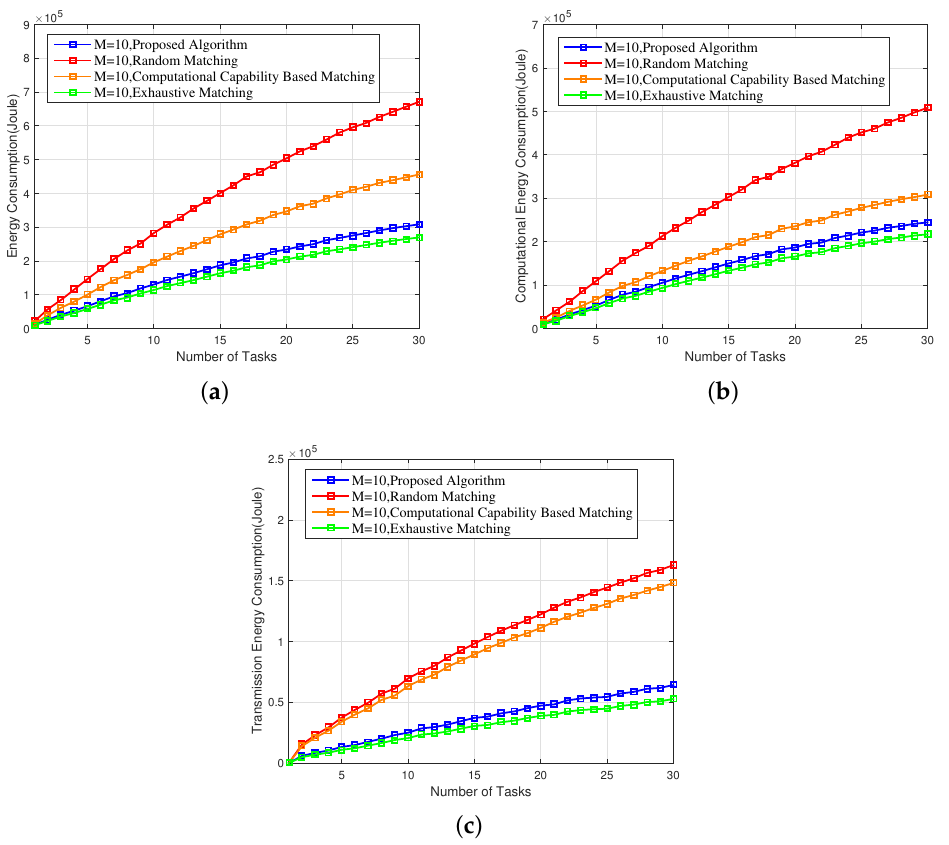
Figure 3. ( a ) Overall energy consumption, ( b ) computational energy consumption, and ( c ) transmission energy consumption of the proposed scheme versus the random matching, CCBM, and exhaustive